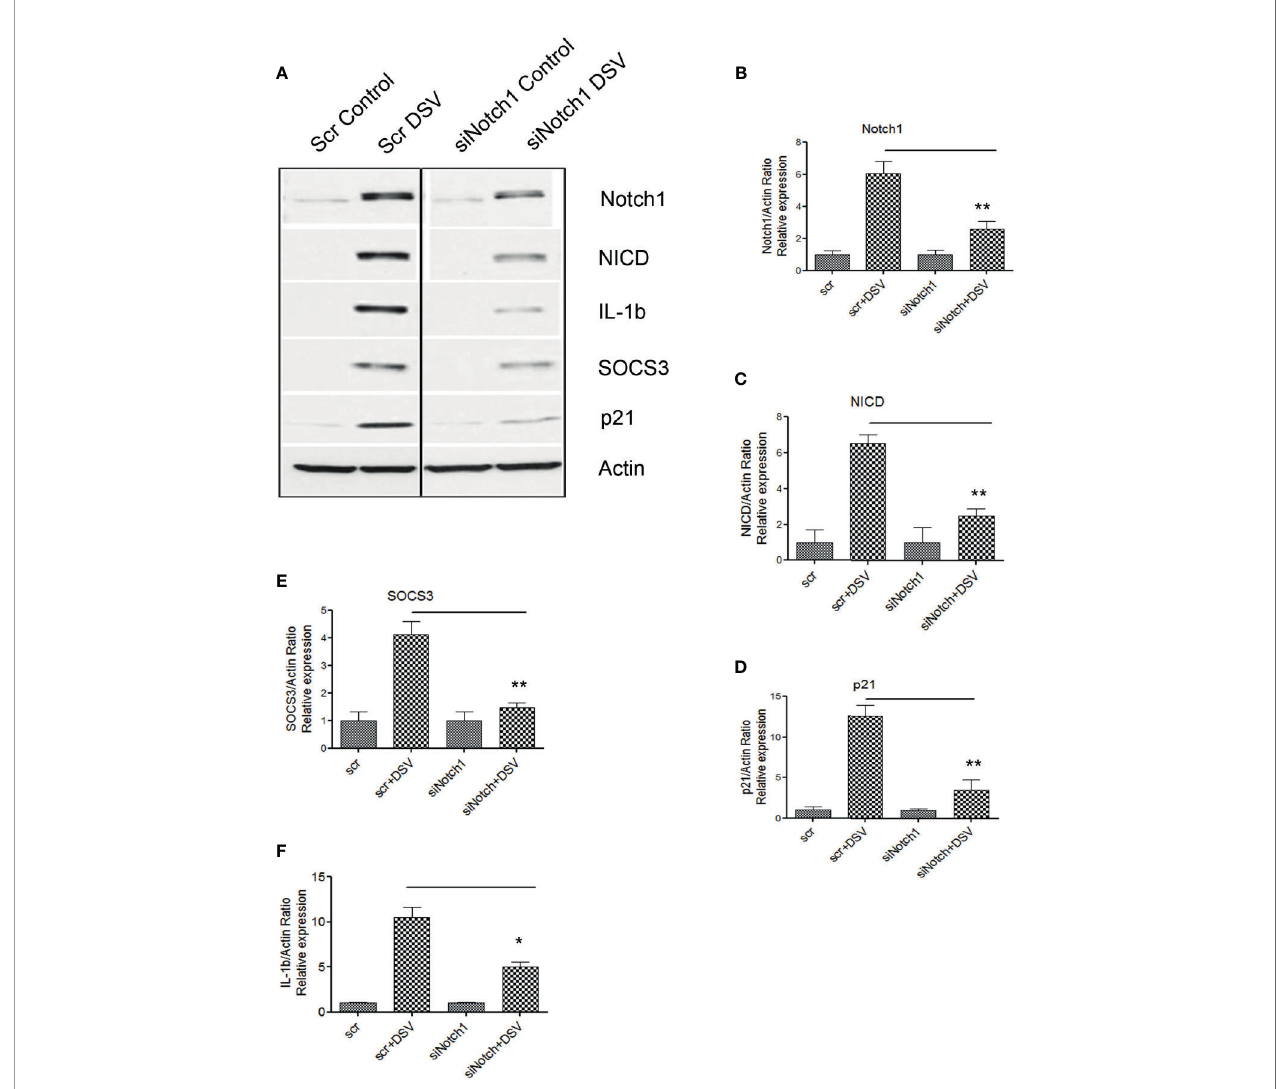
FIGURE 4 | DSV-induced Notch signaling, SOCS3, and IL-1 b expression is inhibited by Notch1siRNA (A) RAW cells were transfected with either scrambled (Scr) or siRNA against Notch1 (siNotch1) by electroporation. After incubation for 24 hours, cells were removed and re-plated at a density of 8x10 5 and further incubated for 24 hours. Following day (total of 48 hrs transfection), cells were infected with DSV (MOI 20) for 7 hours. Cells were lysed and protein lysate was prepared. Fifty m g of protein lysate was separated on SDS-PAGE and analyzed for Notch1, NICD, SOCS3, IL-1 b , and p21 by Western blotting. Actin was used as a loading control. (B – F) Quanti fi cation of Western blots. Blots were quanti fi ed with ImageJ by analyzing the ratio of protein of interest/Actin. Data represents Mean ± SEM from at least three independent experiments. One-way ANOVA was used to determine the statistical signi fi cance. Values were compared to Scr+ DSV, with a post-hoc Dunnett ’ s test. *p < 0.05, **p <